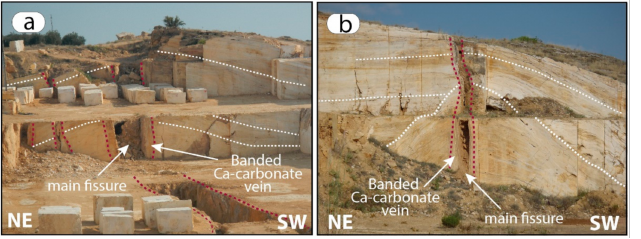
Figure 12. Different banded Ca-carbonate veins cutting travertine deposits migrating through time and giving rise to diachronous fissure ridges (Akkoy, Turkey). ( a ) panoramic view of the Ak-koy fissure ridge and the main fissure running at its top. ( b ) buried fissure ridge related to the pro-gressive ridge